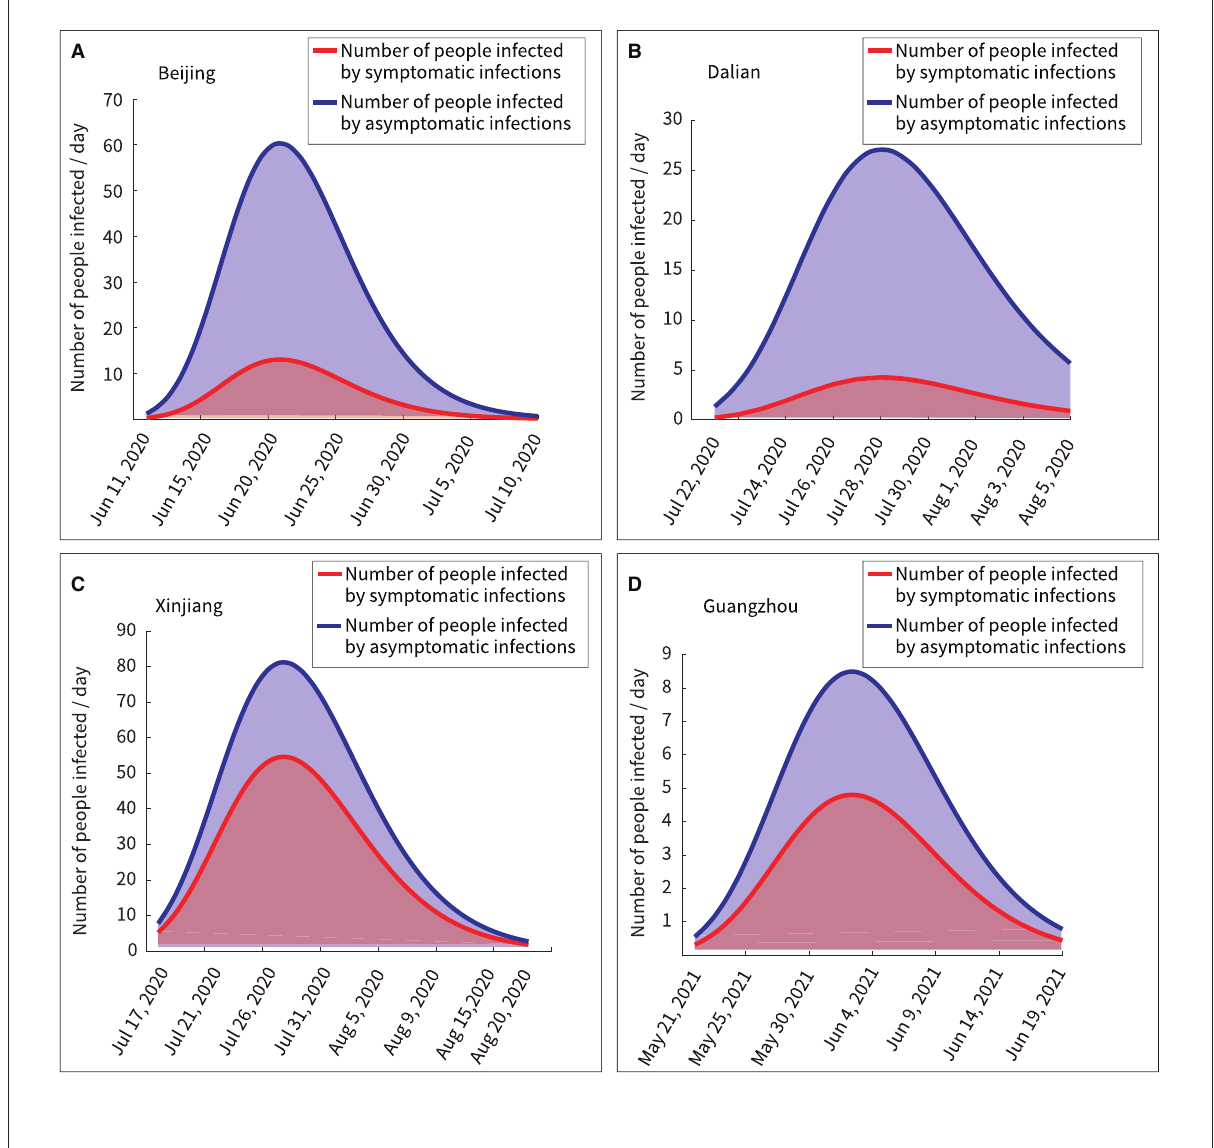
FIGURE8 Quantitative analysis of persons infected by symptomatic and asymptomatic infections. (A) Beijing, (B) Dalian, (C) Xinjiang, (D)